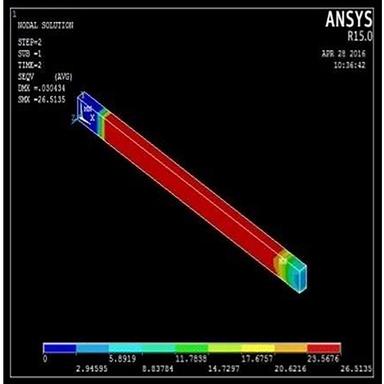
Simulation Results of Compressive Test Specimen at load 510.12 N.